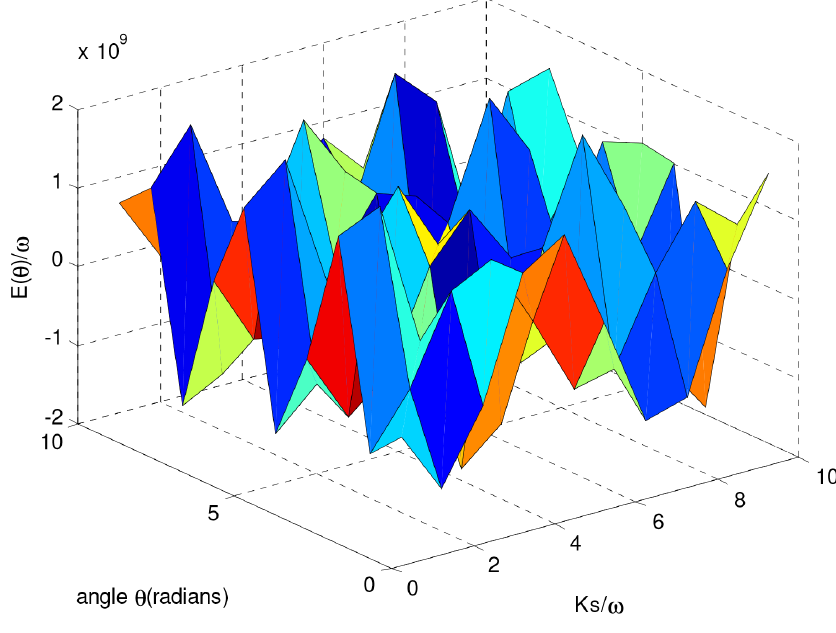
Figure 1: 3-D plot of energy versus angle and stress induced anisotropy for N=2.